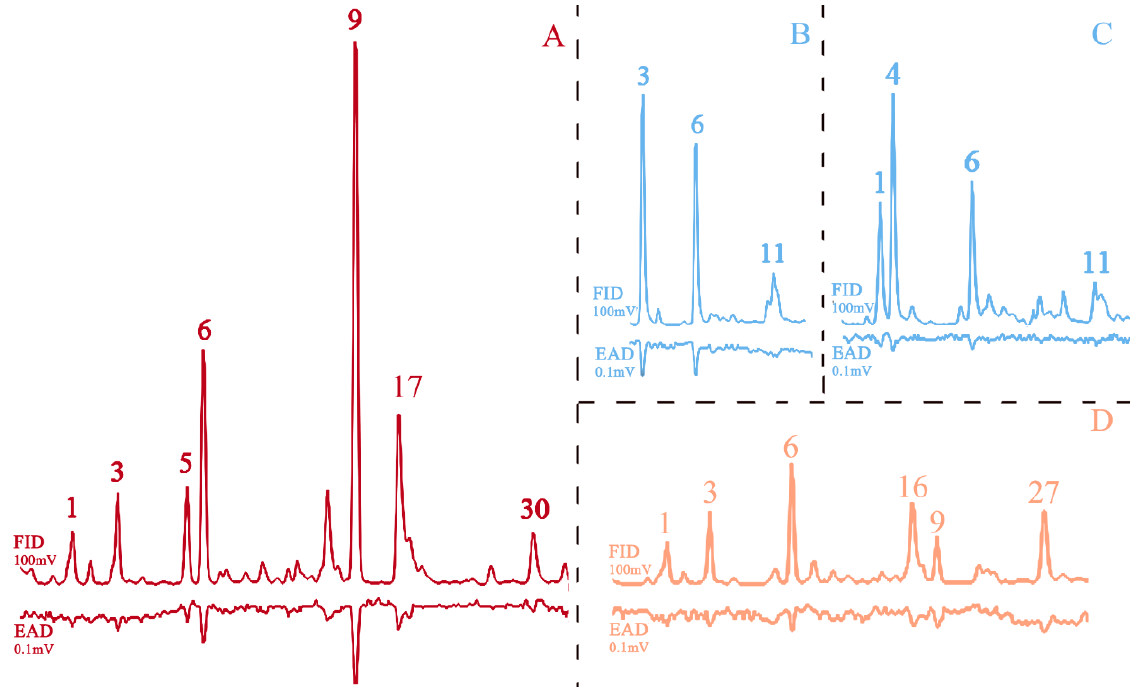
Figure 2. GC-EAD record of eucalyptus trunk and forest floor humus volatiles. A: multi packets; B: forest floor humus; C: non-infested trunk; D: single packet. Peak numbers are the same as Table 1.